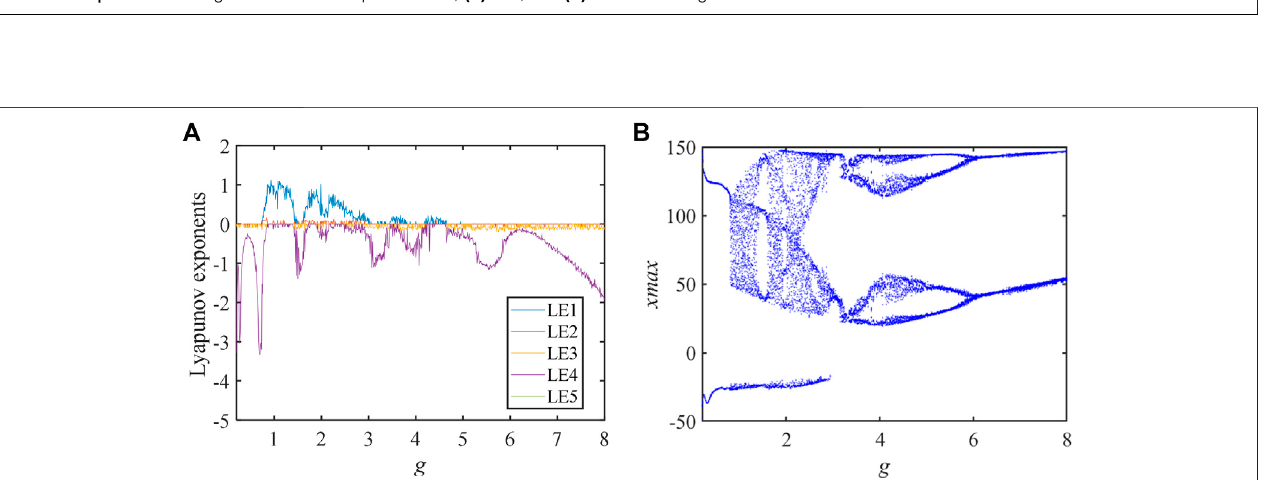
FIGURE 8 | Bifurcation diagram and LEs with parameter g , (A) LEs, and (B) bifurcation diagram.